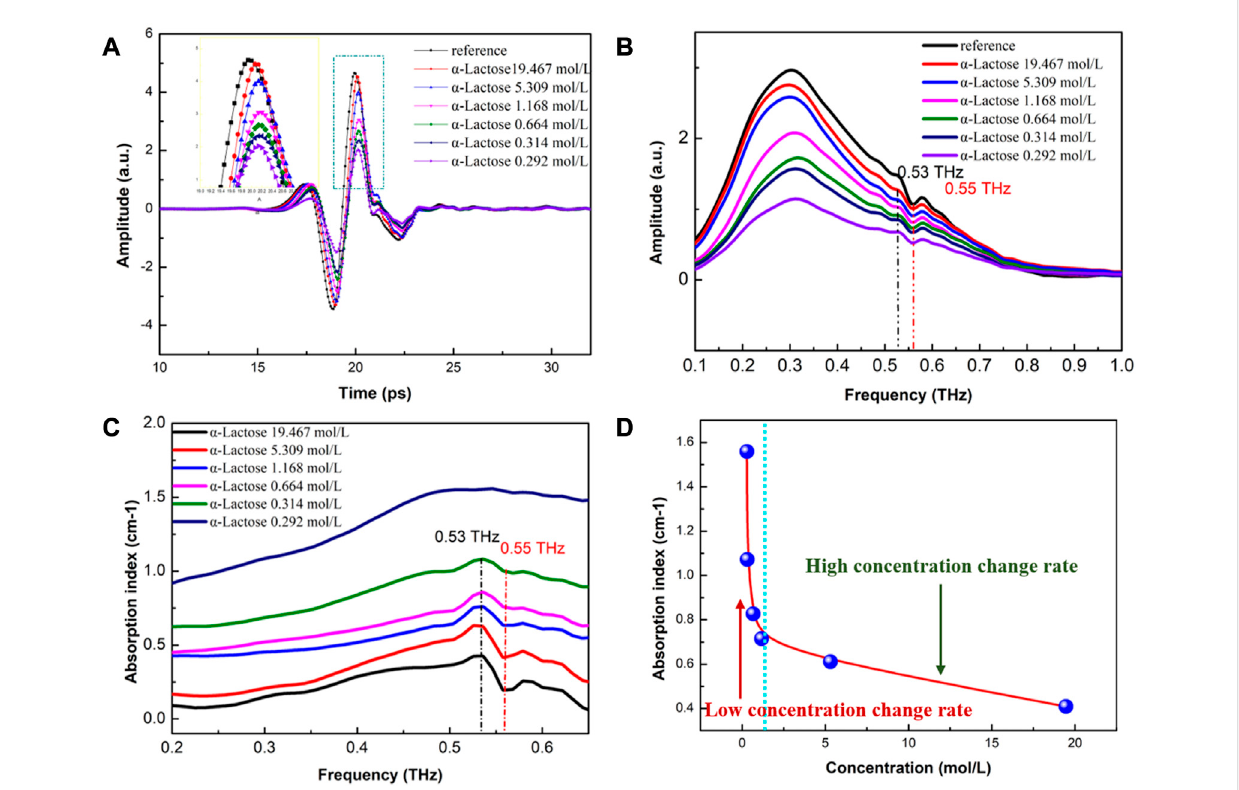
FIGURE 6 High-power THz-ATR spectra of α -lactose samples with different concentrations (A) Time-domain spectra (see enlarged image for details); (B) The corresponding frequency-domain spectra; and (C) Characteristic absorption spectra; and (D) The change rate of absorption peak position with different concentrations of α -lactose